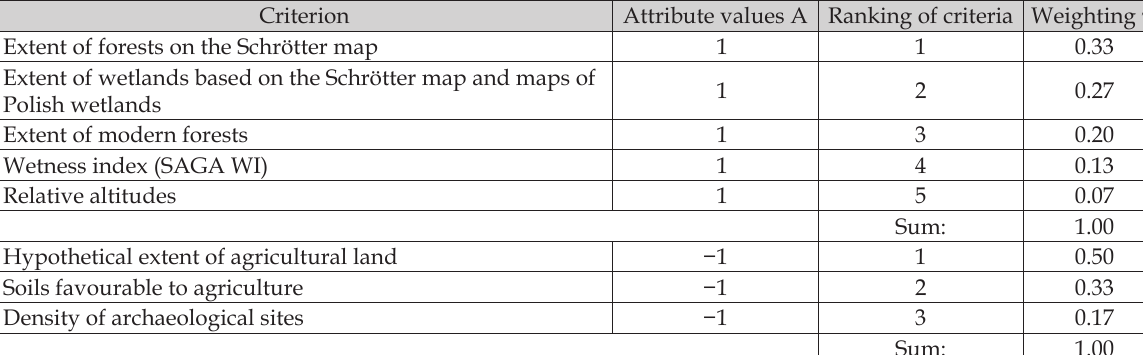
Table 1. Criteria of potential forest area of the research